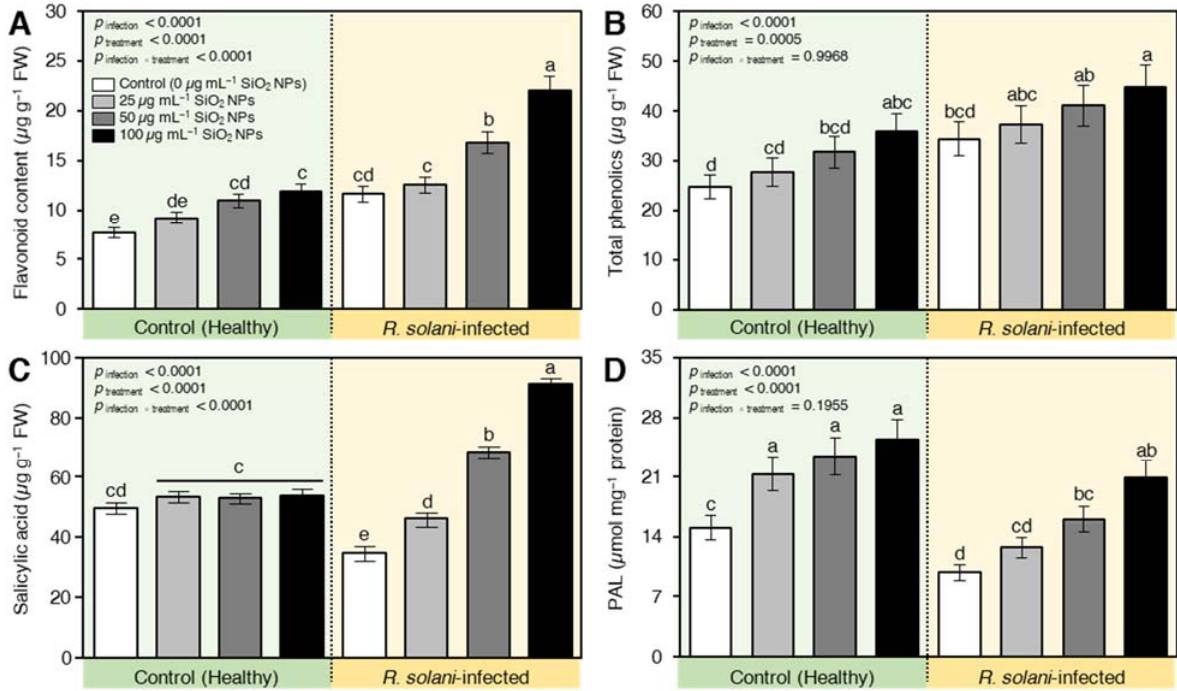
Figure 8. Effect of silicon dioxide nanoparticles (SiO 2 NPs) on defense ‐ related compounds in wheat seedlings infected by R. solani. ( A ) Flavonoid content ( μ g g − 1 FW), ( B ) Total phenolics ( μ g g − 1 FW), ( C ) Salicylic acid ( μ g g − 1 FW), and ( D ) phenylalanine ammonia ‐ lyase (PAL; a key SA biosynthesis enzyme) ( μ mol mg − 1 protein). Data presented are means ± standard deviation (mean ± SD) of five biological replicates. Different letters indicate statistically significant differences among treatments, while the same letters signify no significant differences between them according to Tukey’s honestly significant difference test ( p < 0.05).